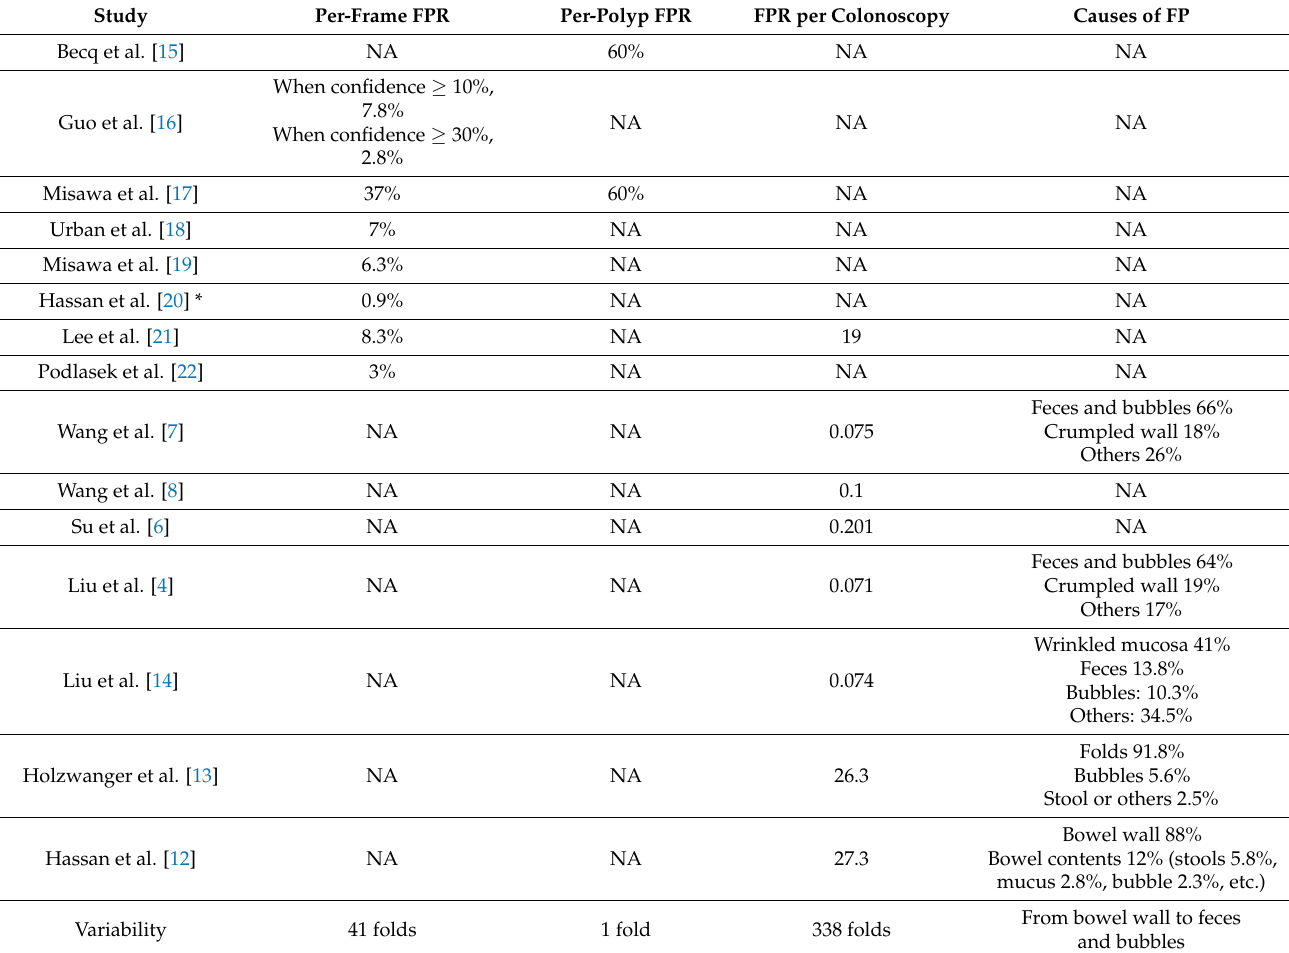
Table 1. Various definitions of false positives and false positive rates across studies.